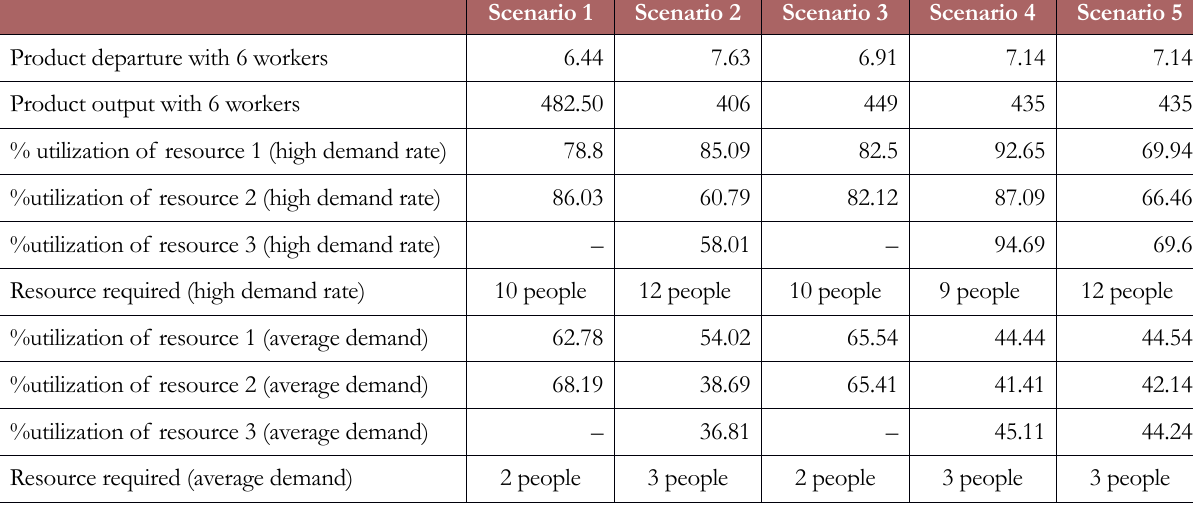
Table 19. Performance for Each Improvement